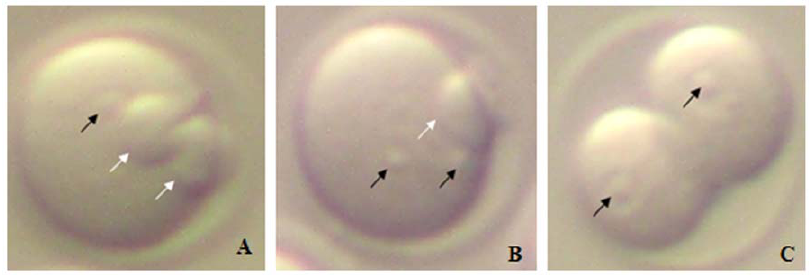
Figure 1. Parthenogenetically activated oocytes ( 6 300) with pronucleus (PN) and polar body (PB). The black arrow shows PN and the white arrow shows PB. A: The activated oocyte with 1 PN and 2 PB. B: The activated oocyte with 2 PN and 1 PB. C: The activated oocyte with 2